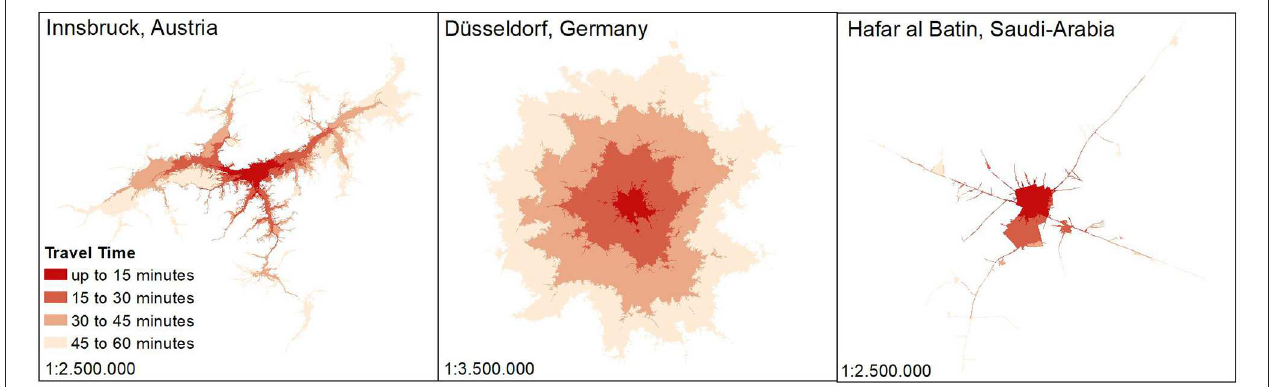
FIGURE 1 | Examples of travel time polygons.